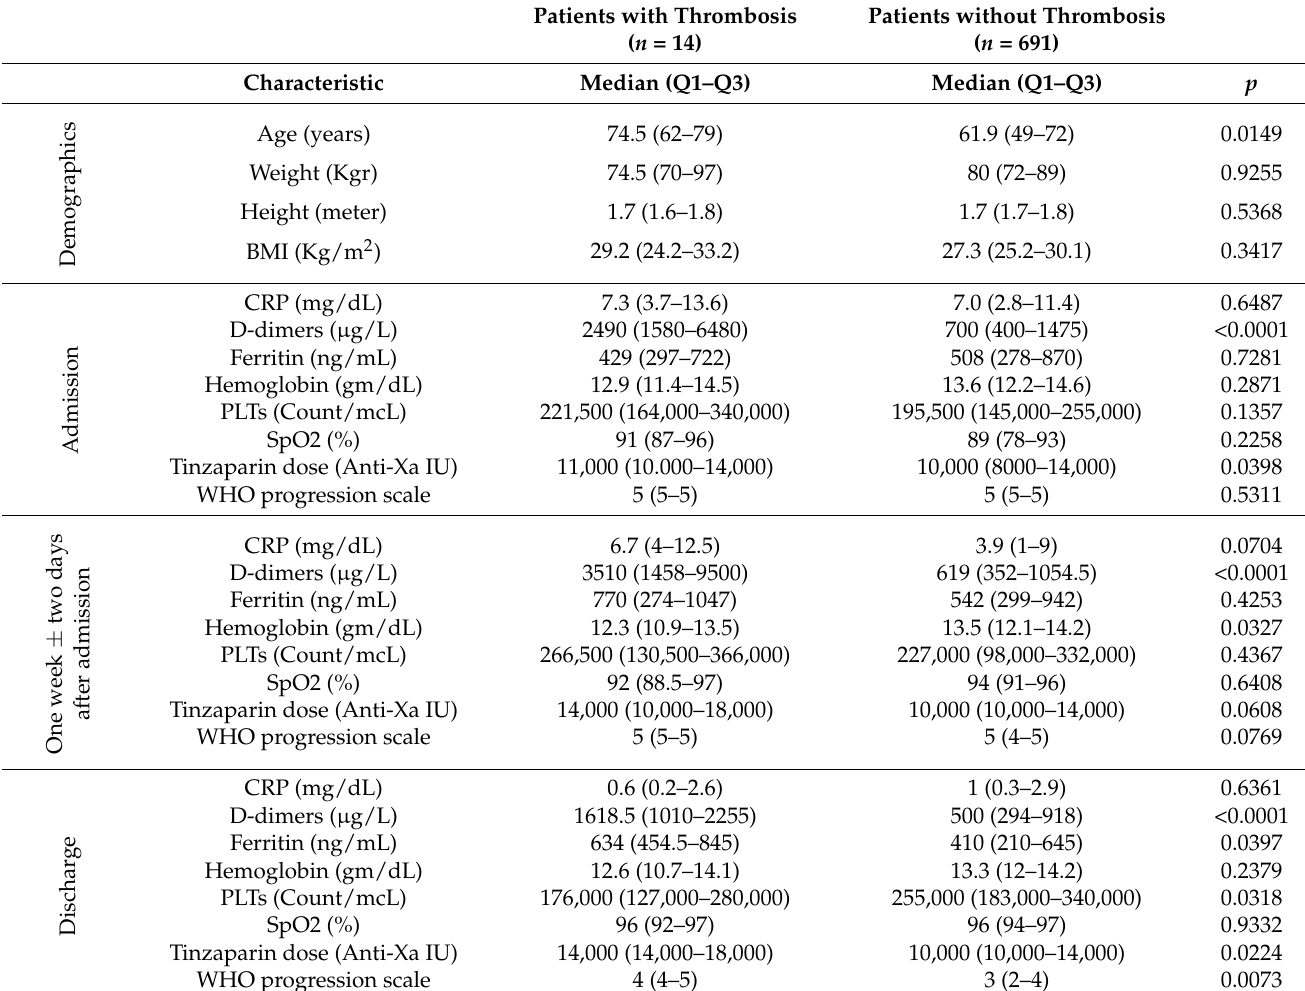
Table 3. Demographic, clinical, and laboratory data of the study population according to the